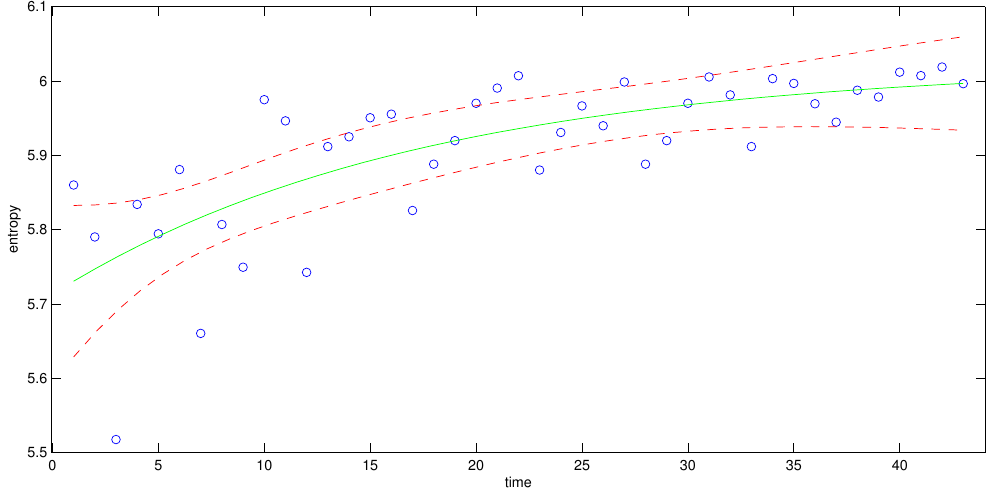
Figure 4: Plot of the original data (the circular points), basic global model (the connected curve), and 95 % confidence band of the regression (the region be- tween the dashed